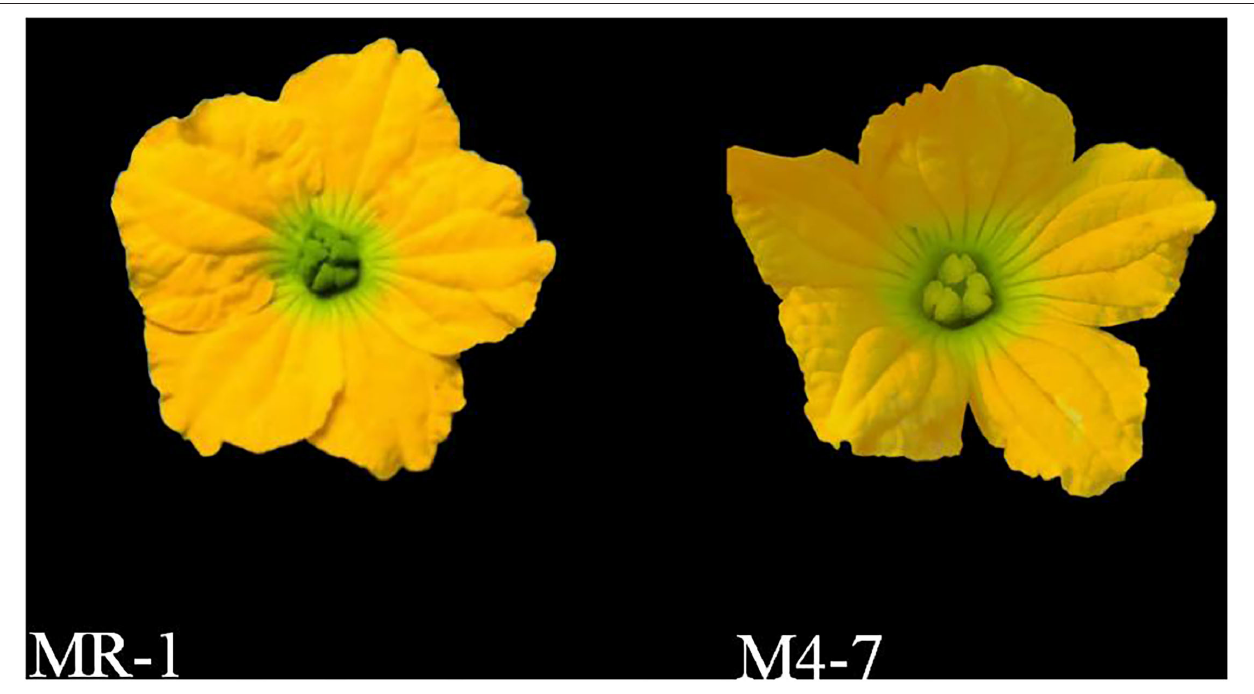
FIGURE 1 | The primary phenotypes of MR-1 and